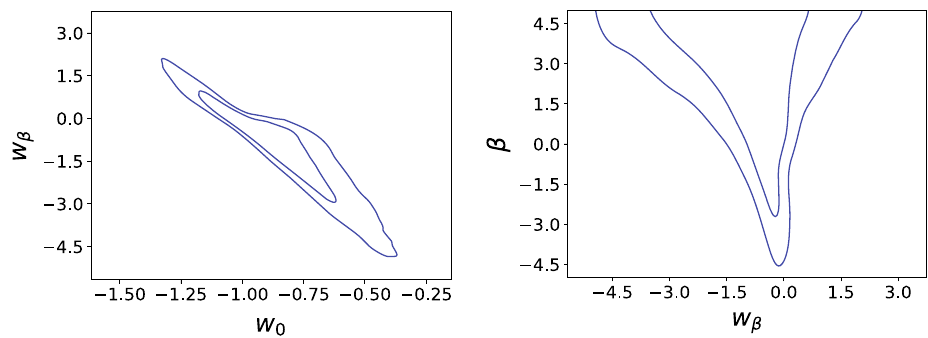
Fig. 1 The 68.3 and 95.4% confidence level contours for w 0 versus w β and w β versus β for the standard ruler data. The best fit happens at w = − 0 . 94, w β = 0 . 17 and β = − 1 . 0